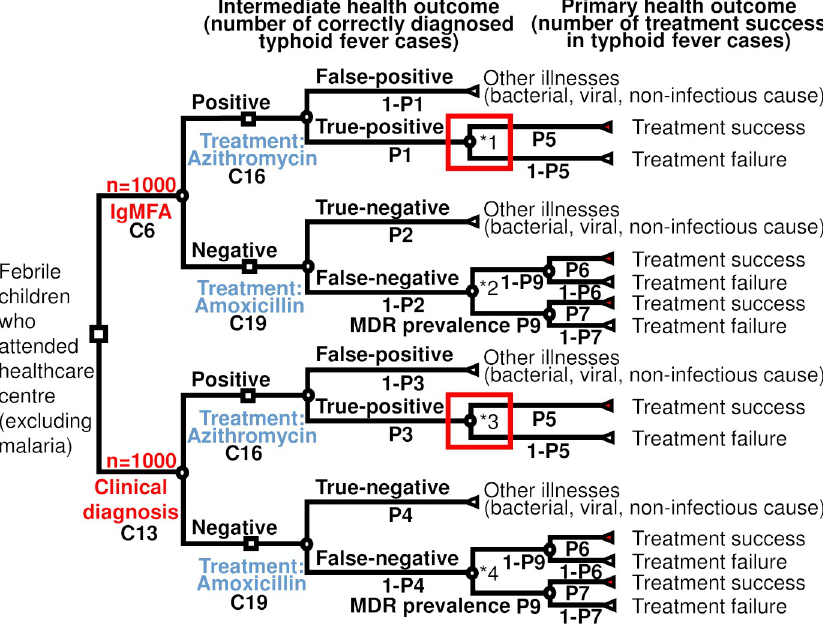
Fig 1. Decision tree model for diagnosis and treatment for typhoid fever. � MDR strains exist equally among true- positives and false-negatives. Since probability of treatment success in azithromycin is the same between MDR strains and non-MDR strains, � 1 and � 3 are not branched to P9 and